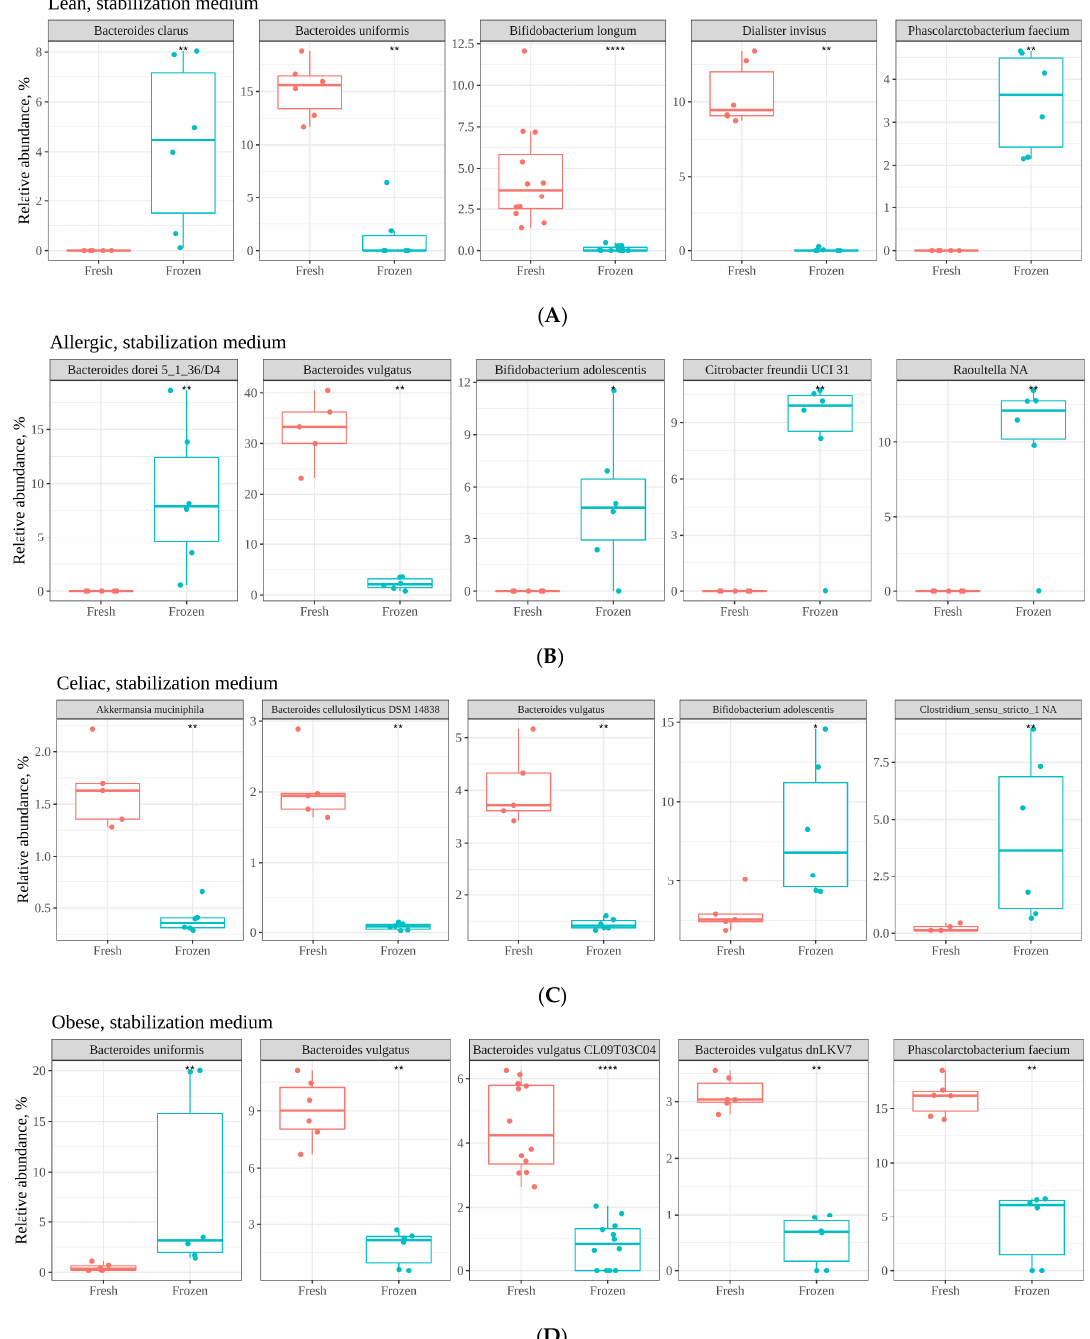
Figure 4. Top five discriminant ASVs between fresh and frozen samples in the stabilization medium, as determined via OPLS-DA. ( A ) show the results obtained with fecal samples of lean children. ( B ) show the results obtained with fecal samples of children with allergy to cow’s milk. ( C ) show the results obtained with fecal samples of celiac children. ( D ) show the results obtained with fecal samples of obese children. Statistical significance was obtained via Wilcoxon test ( p < 0.05). Significance labels: ns: not significant; * p < 0.05; ** p <